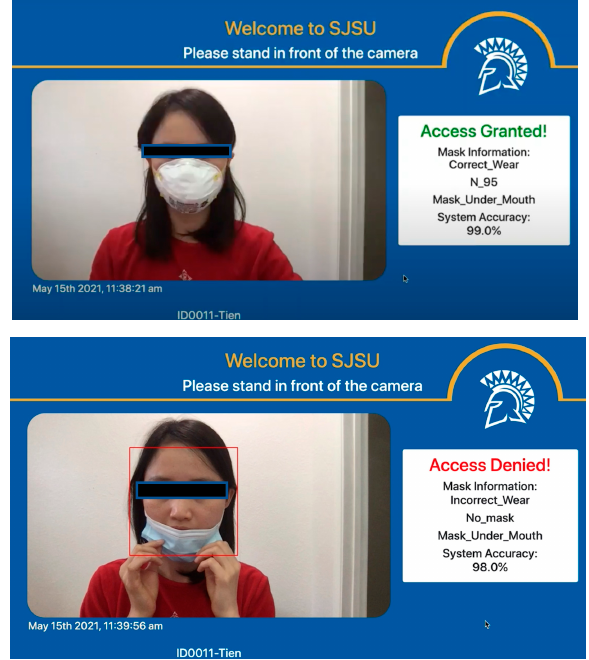
Figure 17. Screenshot of System User Interface.